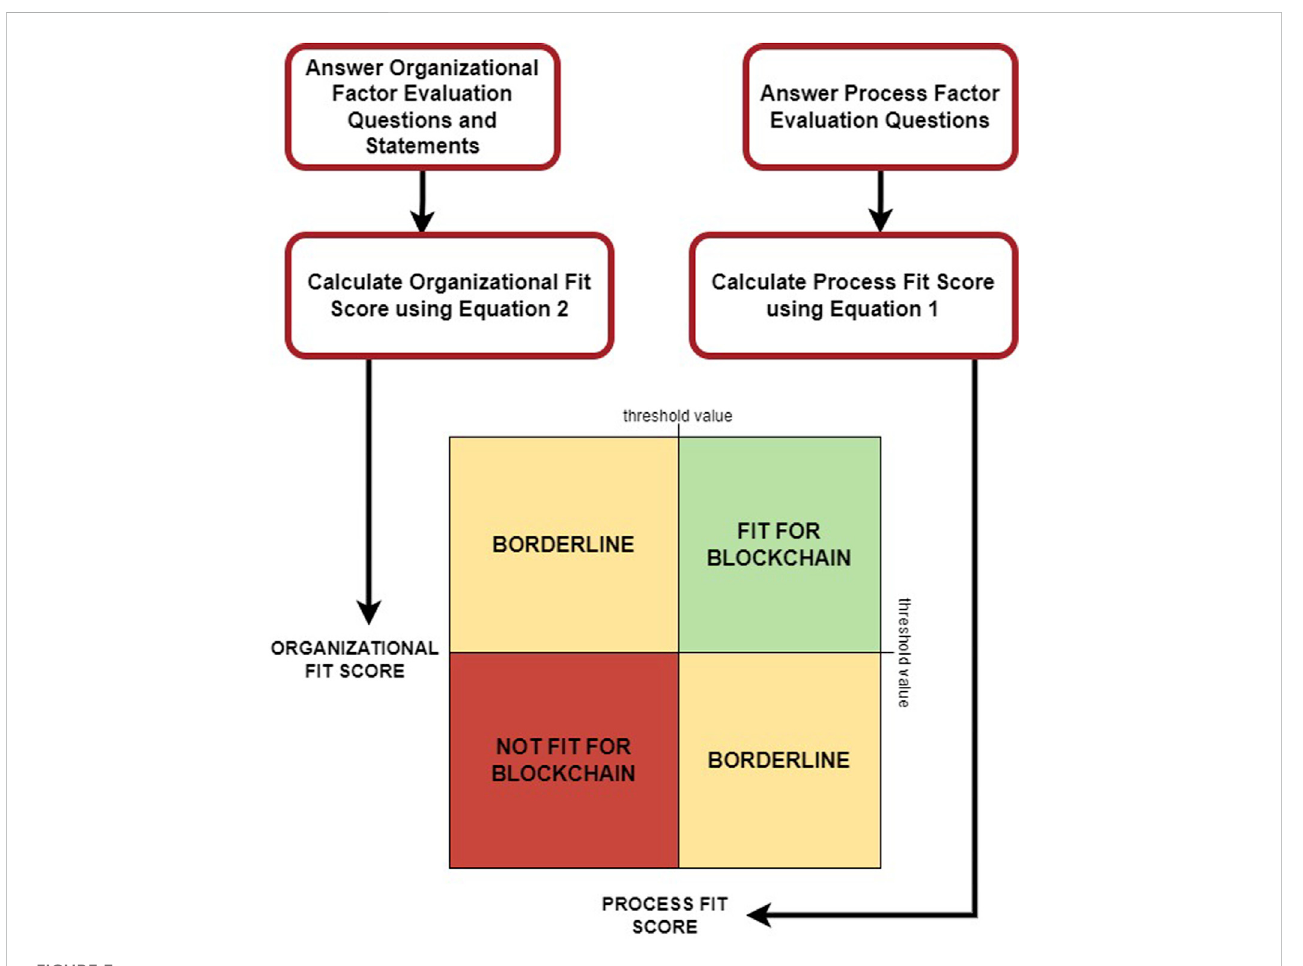
FIGURE 3 Blockchain Fit Analysis